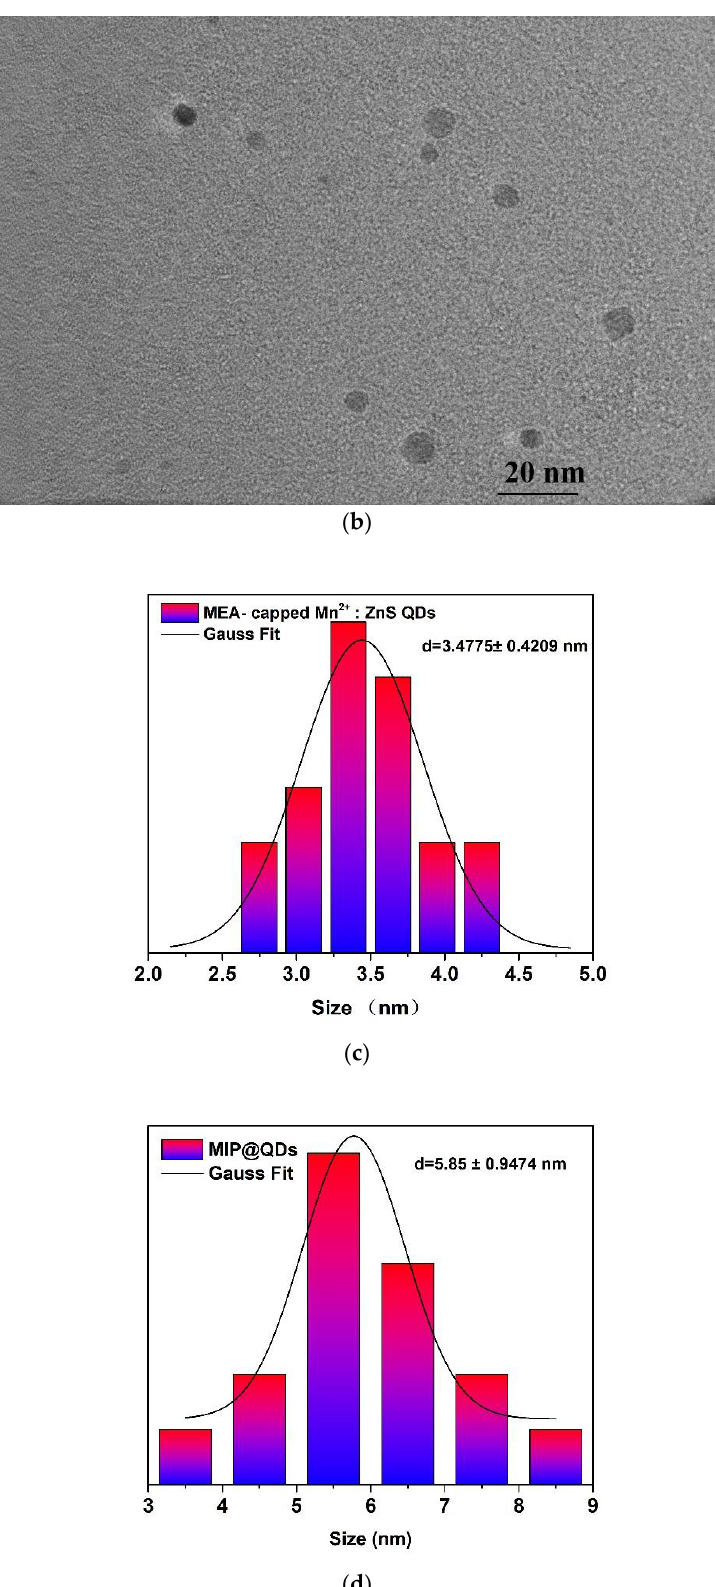
Figure 3. TEM images of ( a ) MEA-capped Mn 2+ : ZnS QDs, ( b ) MIP@QDs, and particle size distribu- tion of ( c ) MEA-capped Mn 2+ : ZnS QDs and ( d ) MIP@QDs.